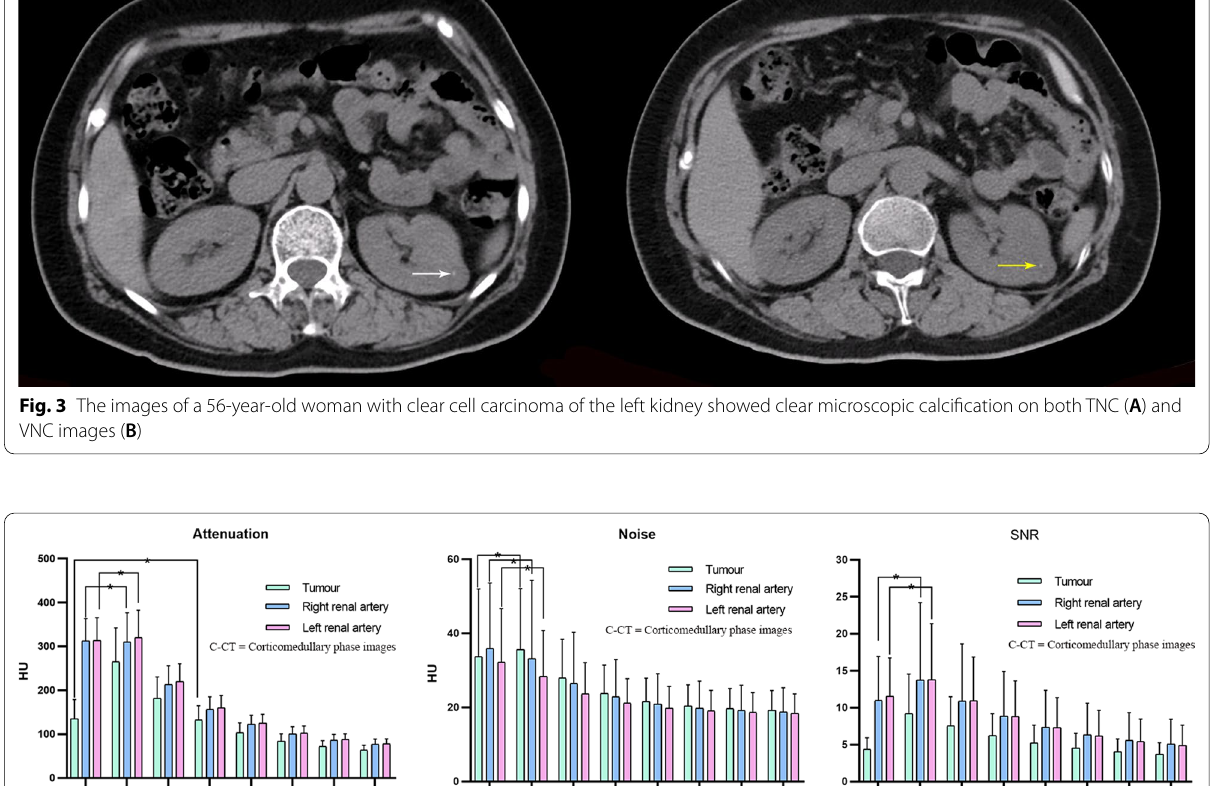
Table 3 Qualitative analysis of the image quality and lesion visibility Group Reader 1 Reader 2 Kappa